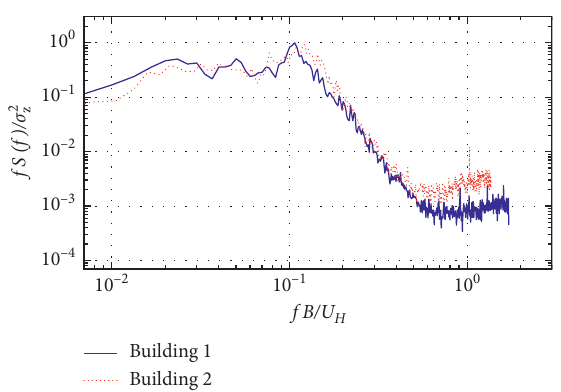
Figure 4: Normalized PSD of base shear forces at the across-wind Table 2: Information of 22 considered earthquakes from FEMA P-695 far-field record set [46]. ID no.